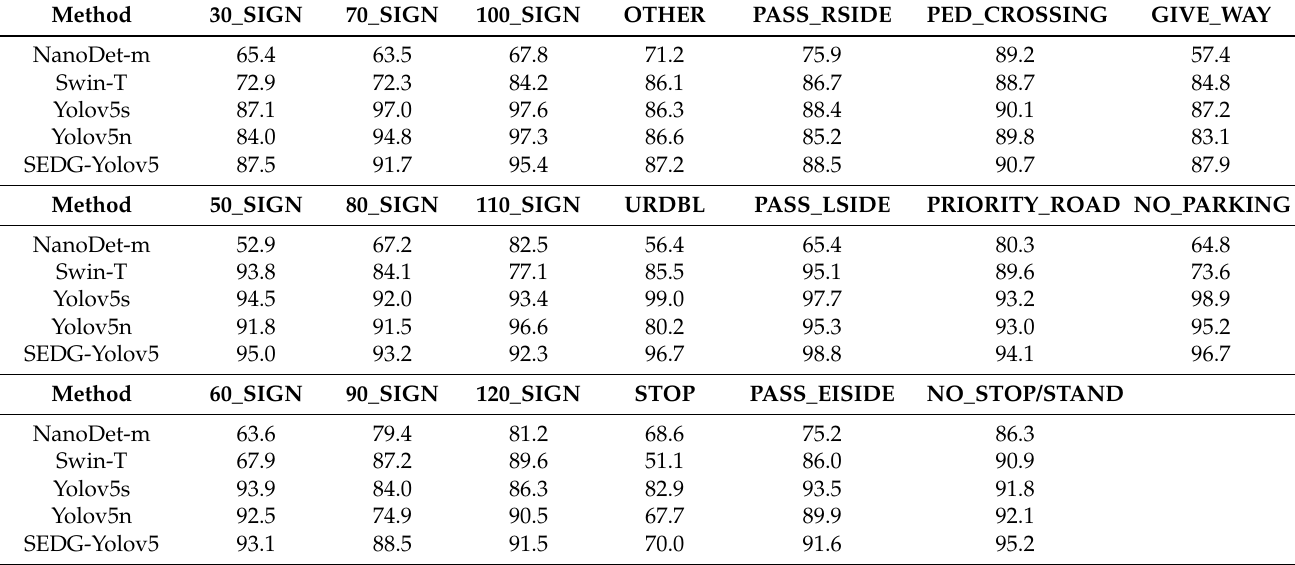
Table 5. Comparison of results for F1-score on the STSD dataset (in